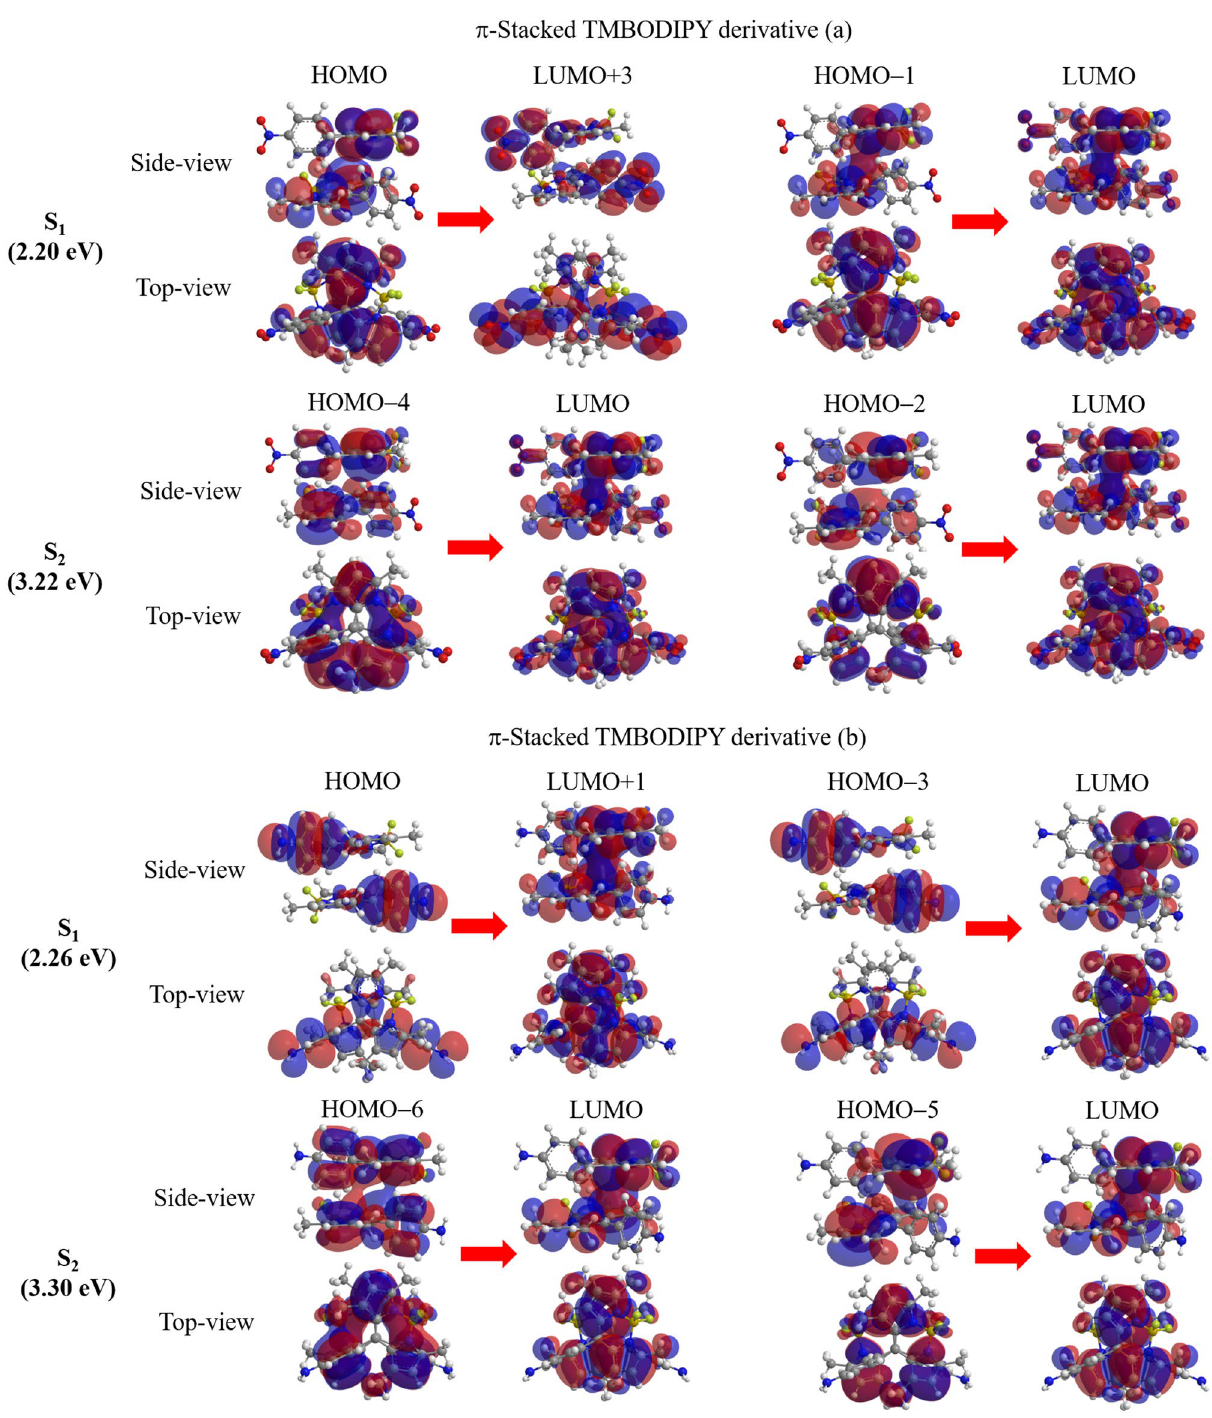
Figure 4. Molecular orbital images corresponding to the main transitions of the S 1 and S 2 excitations of π -stacking TMBODIPY derivatives ( a ) and ( b ) dimers in acetonitrile solvent. The transitions are given in SF-LC-TDBLYP/cc-pVTZ calculations, while the molecular orbital images are obtained in LC-BLYP/cc-pVTZ calculations